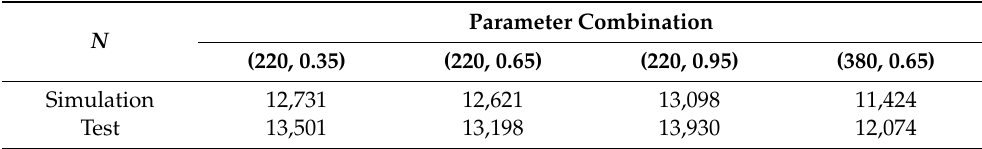
Table 2. The electrical life of the LVCB under different parameters. Parameter Combination N (220, 0.35) (220,